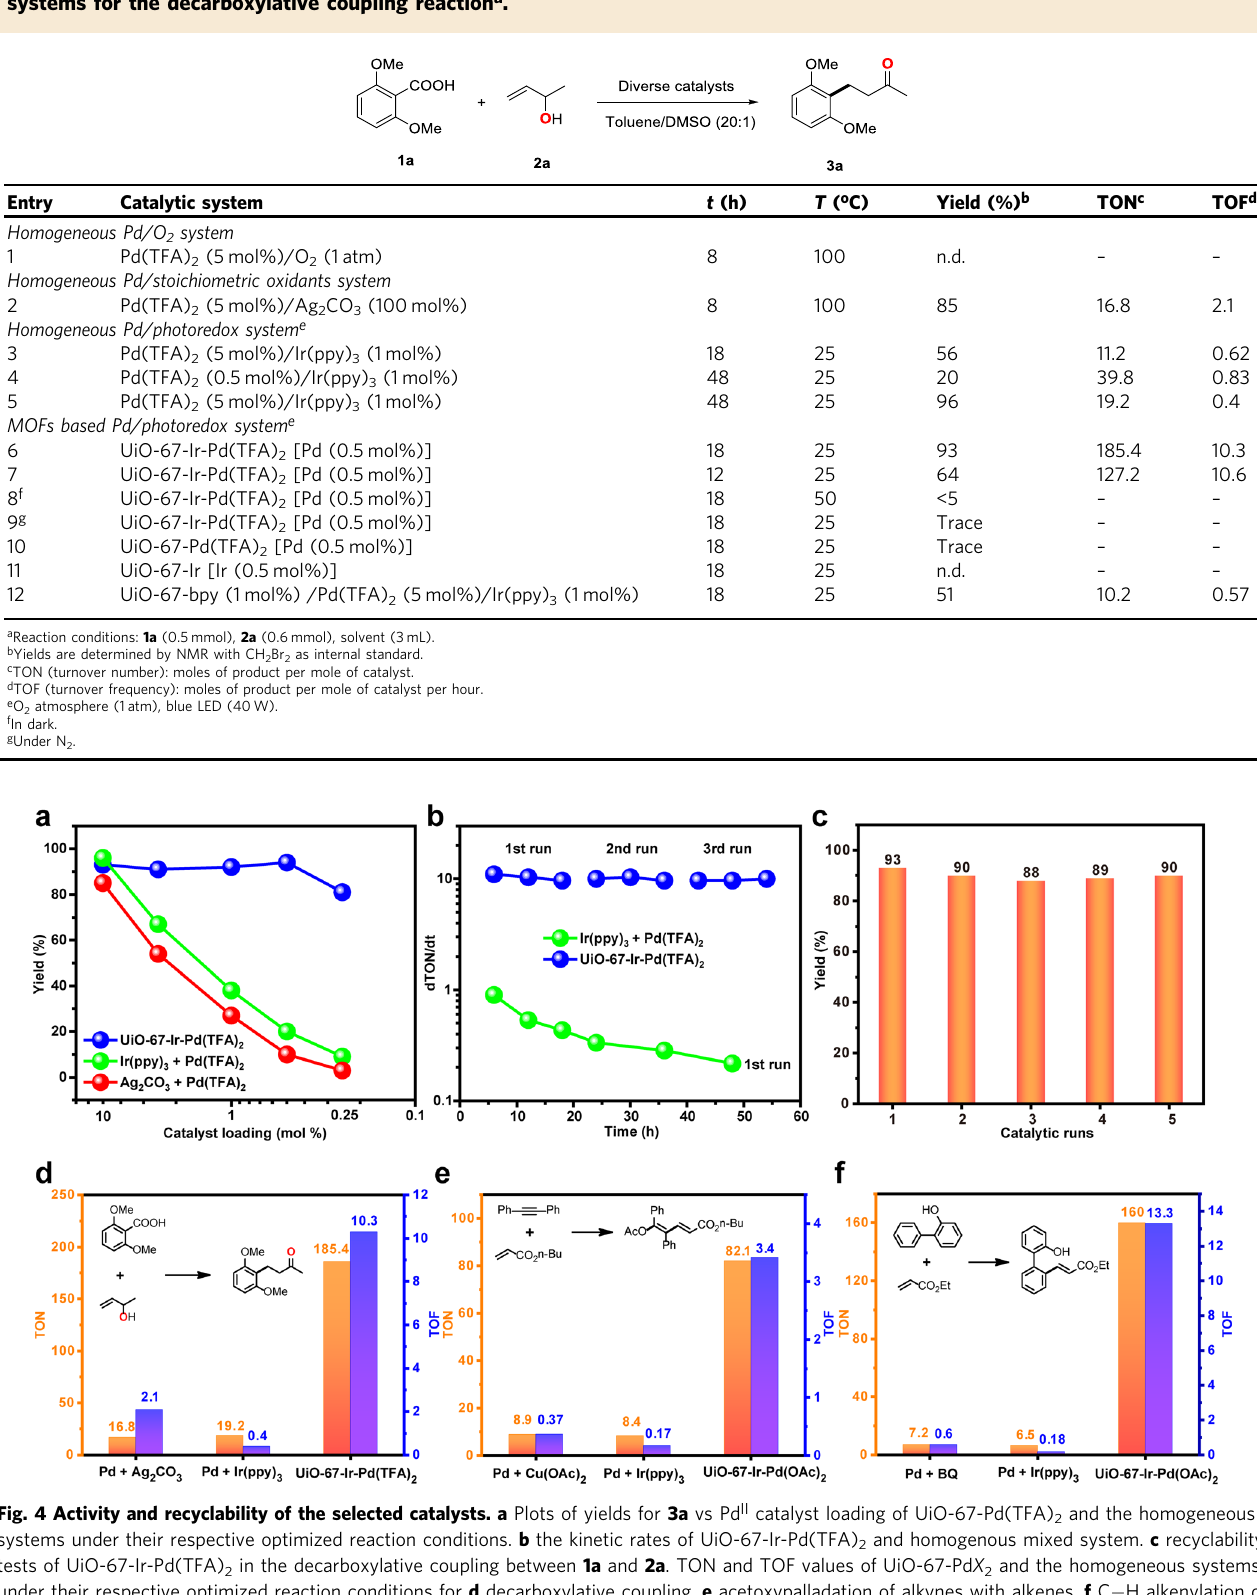
Table 1 Comparison of the homogeneous Pd/O 2 , Pd/stoichiometric-oxidant, Pd/photoredox and MOFs based Pd/photoredox systems for the decarboxylative coupling reaction a .